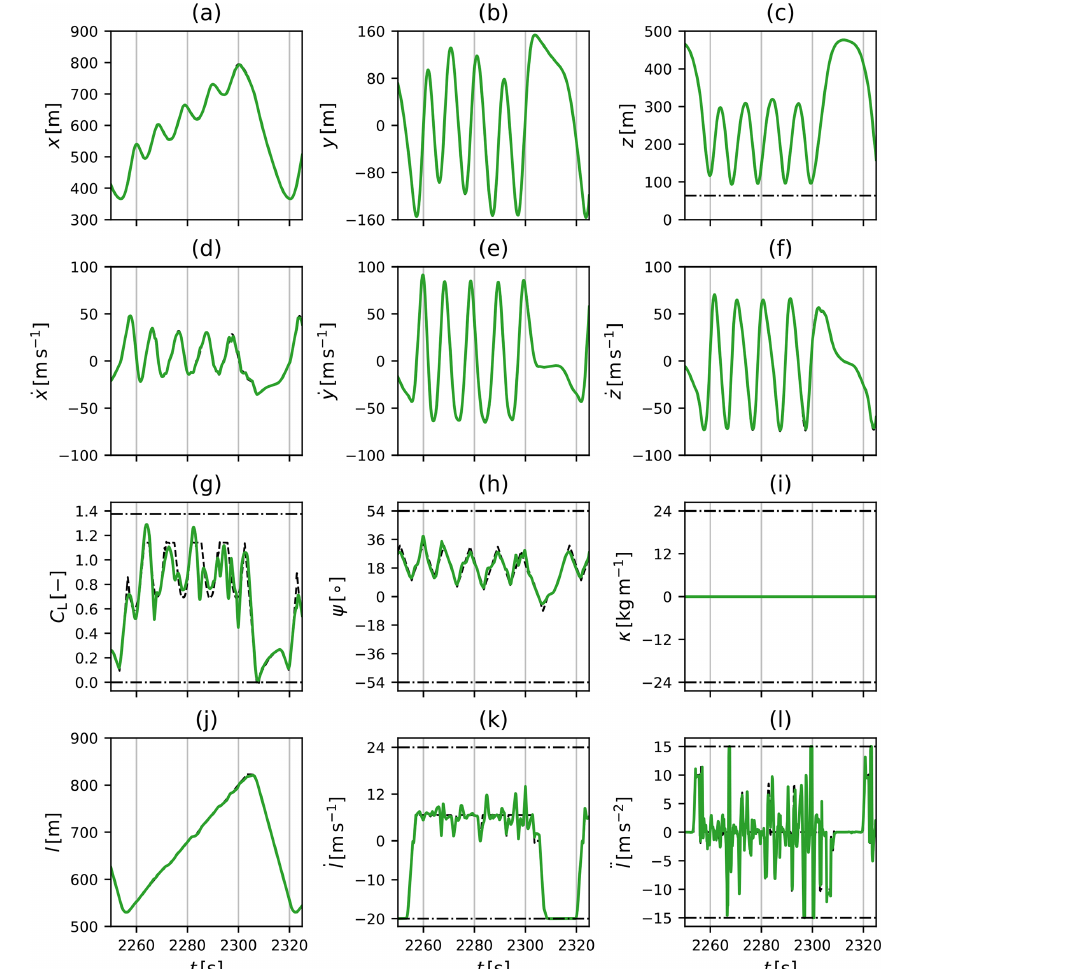
Figure B5. Instantaneous states measured at the point mass of the lift-mode AWE system 003 (park L1) compared to their reference values. The position q and velocity ˙ q are respectively shown in (a–c) and (d–f) . The wing lift coefficient C L , roll angle (cid:57) , and on-board turbine thrust coefficient κ are shown in (g–i) . The tether variables l , ˙ l , and ¨ l , representing the length, speed, and acceleration of the tether, are shown in (j–l) . The black dashed and dashed–dotted lines respectively represent the variable references and the eventual constraints applied to the variables in NMPC (Eq.